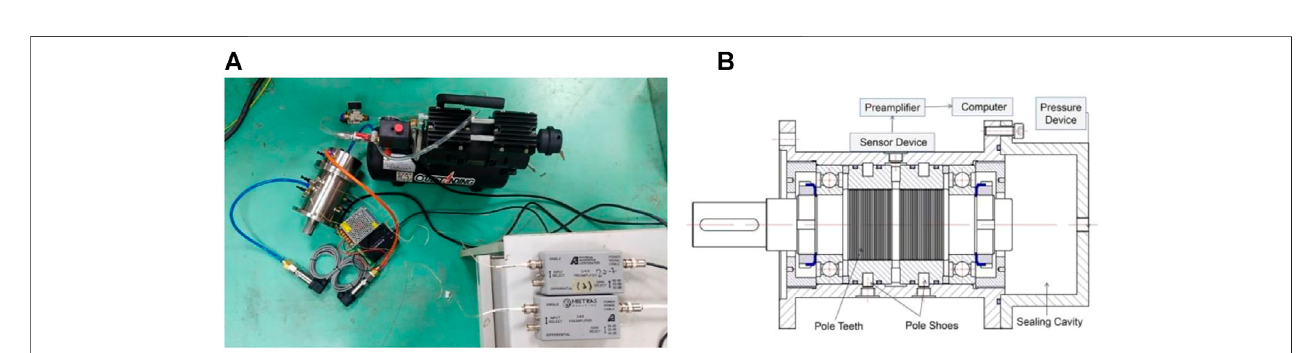
FIGURE 3 | Schematic diagram of magnetic fl uid seal signal acquisition experiment. (A) Device of magnetic fl uid seal signal acquisition experiment, (B) Principle of magnetic fl uid seal signal acquisition experiment.